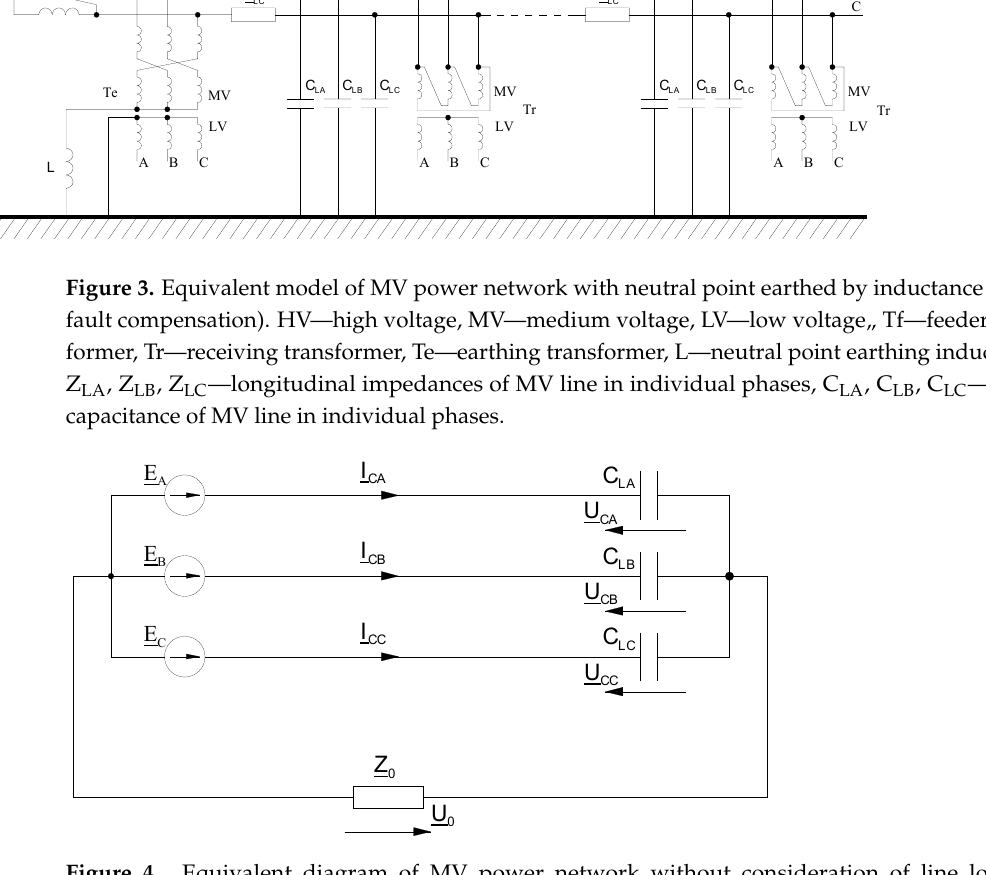
Figure 3. Equivalent model of MV power network with neutral point earthed by inductance (earth fault compensation). HV—high voltage, MV—medium voltage, LV—low voltage,, Tf—feeder transformer, Tr—receiving transformer, Te—earthing transformer, L—neutral point earthing inductance, Z LA , Z LB , Z LC —longitudinal impedances of MV line in individual phases, C LA , C LB , C LC —shunt capacitance of MV line in individual phases.